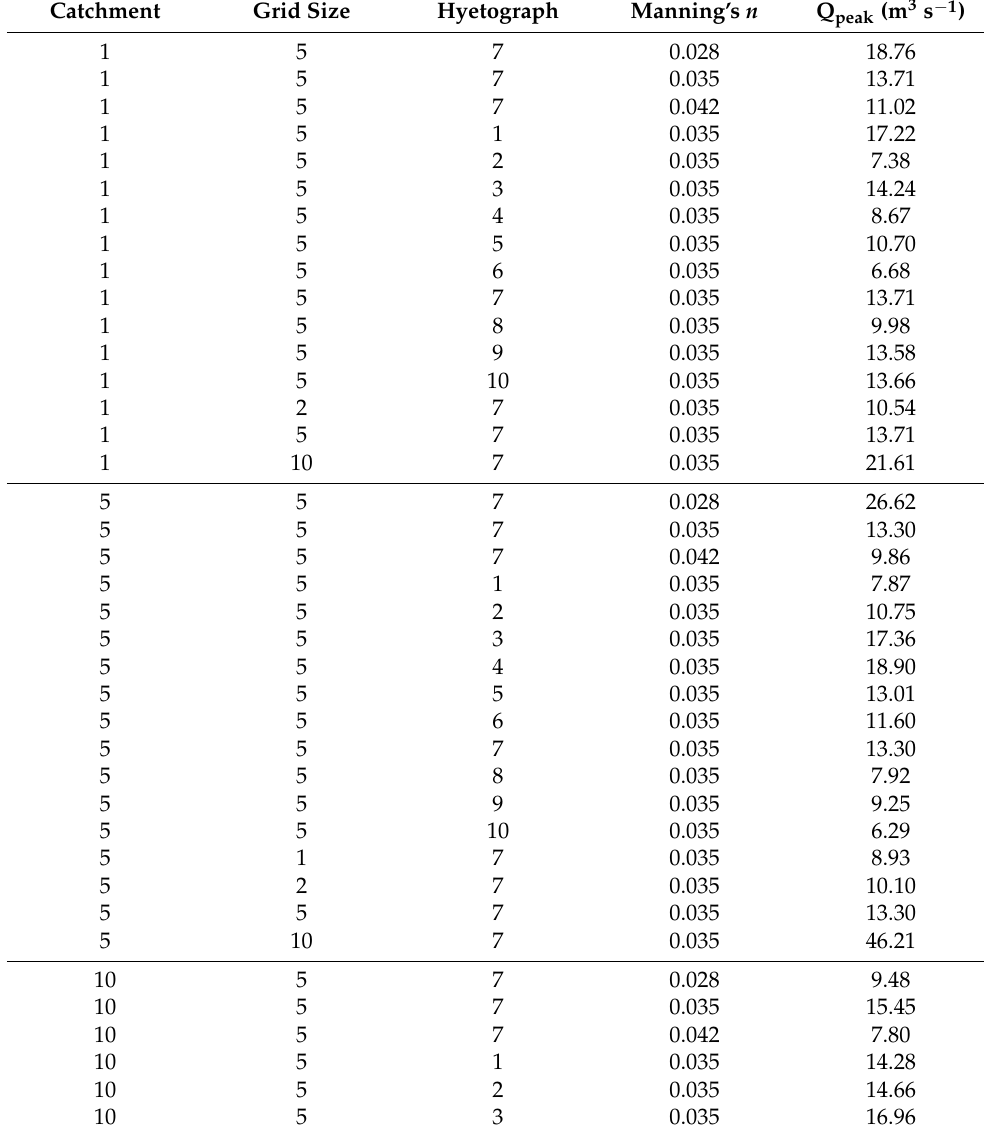
Figure 11. Sensitivity analysis box plot to show results for Catchments 1, 5 and 10 for a Q 20 flood where Manning’s n , hyetograph shape and grid size were adjusted. Table 5. Results of sensitivity analysis catchments 1, 5 and 10 for the